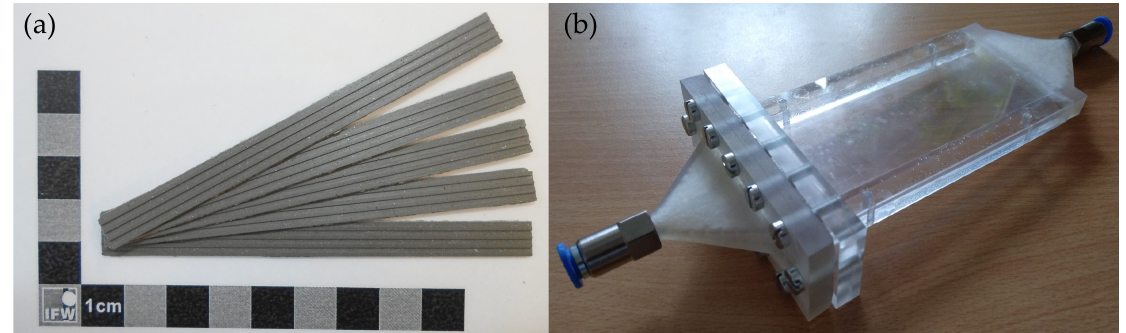
Figure 7. ( a ) Profiled plates of epoxy-bonded LaFe 11.4 Si 1.2 Mn 0.3 H 1.8 powder; ( b ) material chamber for the test magnetic circuit with an openable front side for different material samples.